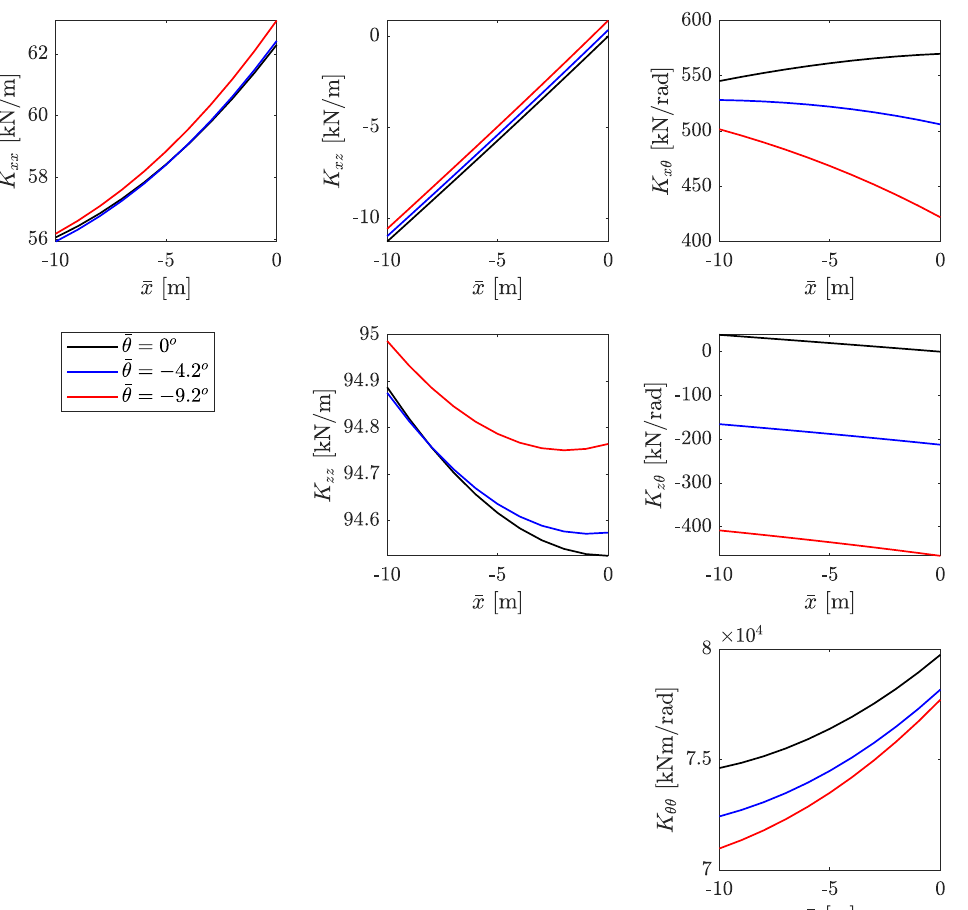
Figure 13. Mooring system stiffness coefficients as functions of surge offset and mean